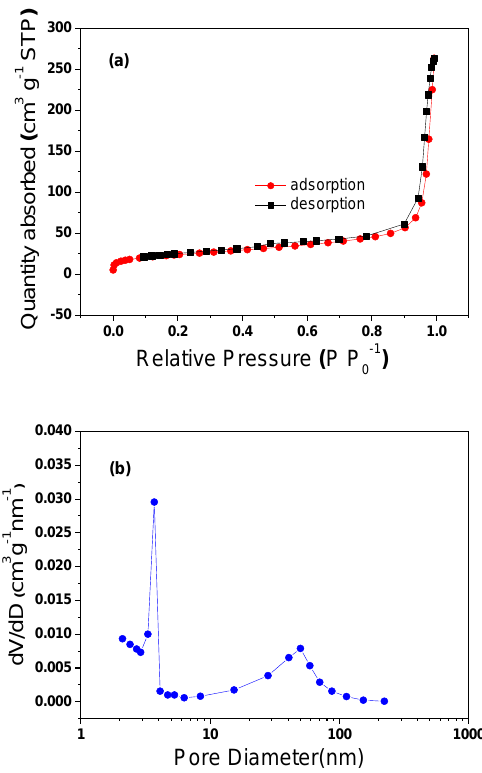
Figure 7. ( a ) Nitrogen adsorption/desorption isotherms and ( b ) the pore size distributions of C@Fe 2 O 3 composites.